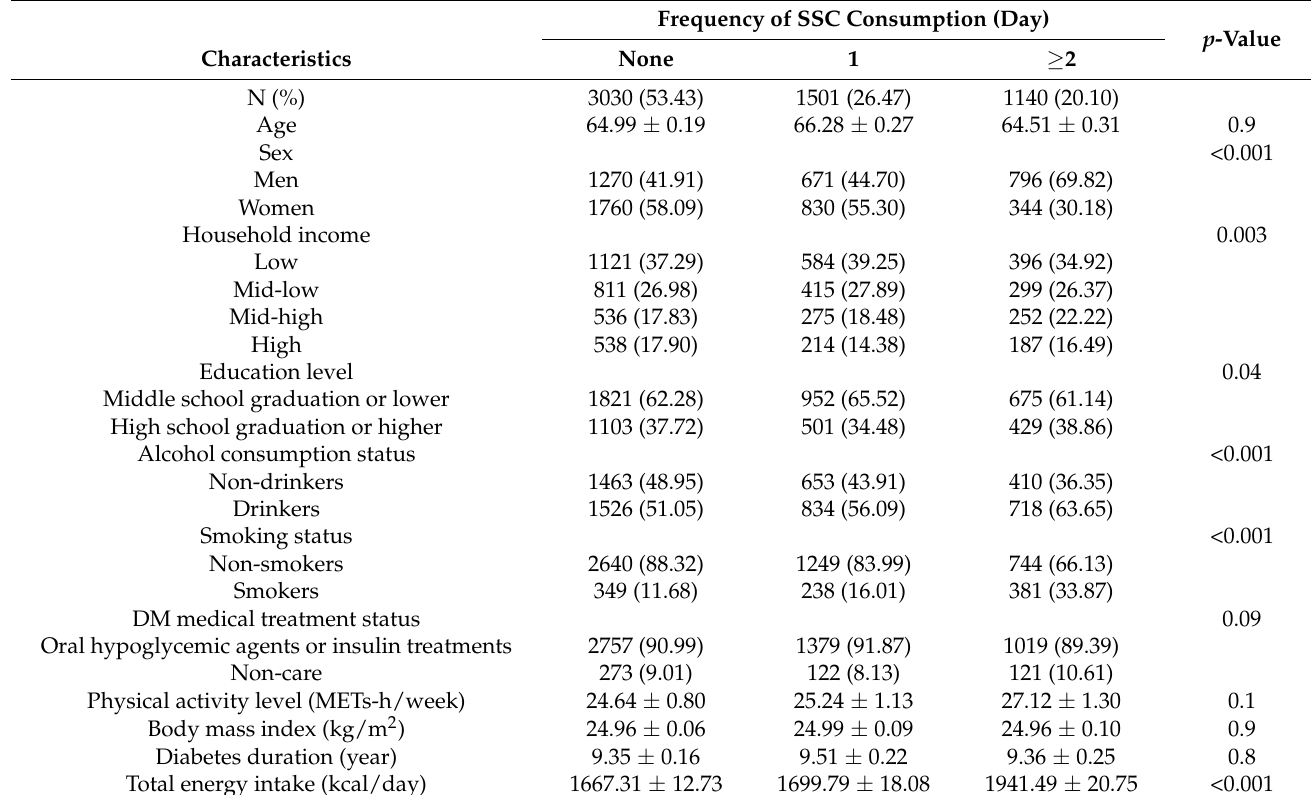
Table 1. Demographic and lifestyle characteristics of participants with diabetes mellitus according to the frequency of sugar-sweetened coffee consumption, KNHANES